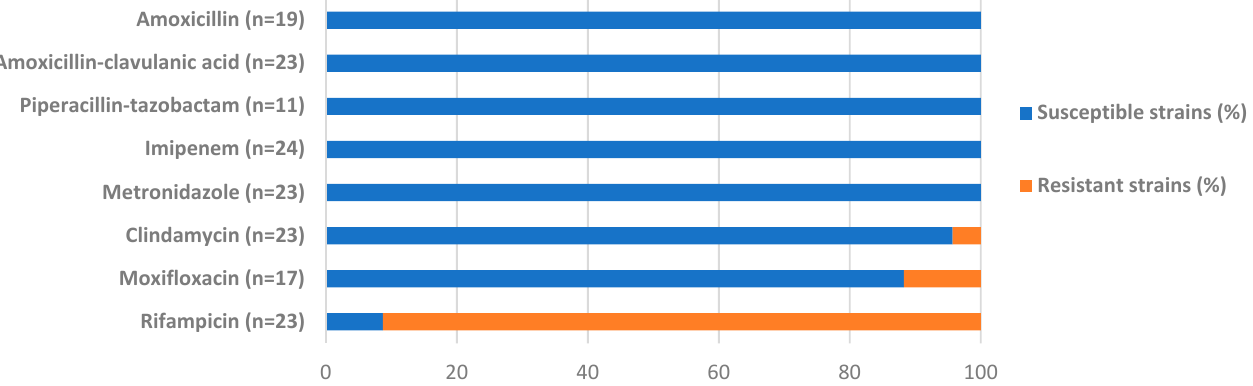
Figure 1. Antimicrobial susceptibility of Solobacterium moorei isolates. The antibiotic molecule is indicated on the left side of the figure, followed by, in brackets, the number of strains with available susceptibility data. * Data for ofloxacin were not included in Figure 1 as they were available for 8 S. moorei strains only: 3 susceptible strains (37.5%), 3 resistant strains (37.5%), and 2 strains with intermediate susceptibility (25%).